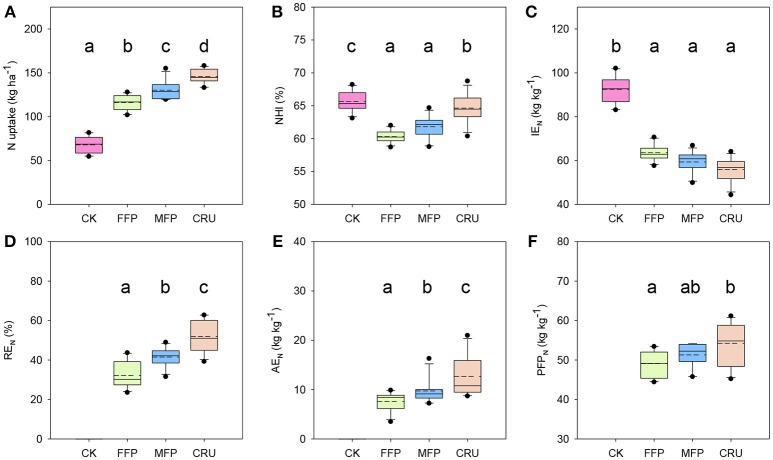
Comparison of nitrogen uptake and use efficiency by different fertilization treatments. (A) N uptake; (B) NHI, N harvest index = N in grains/N uptake; (C) IEN, internal N efficiency = grain yield/N uptake; (D) REN, N recovery efficiency = [plant N accumulation in the plot received N fertilizer (TN) – plant N accumulation in the zero-N control (T0)]/amount of N applied (NA); (E) AEN, N agronomic efficiency = [grain yield in the plot received N fertilizer (GN) – grain yield in the zero-N control (G0)]/NA; (F) PFPN: nitrogen partial factor productivity = GN/NA. Results are pooled from different years and locations. Boxes followed by the same letter are not significantly different at 5% level.